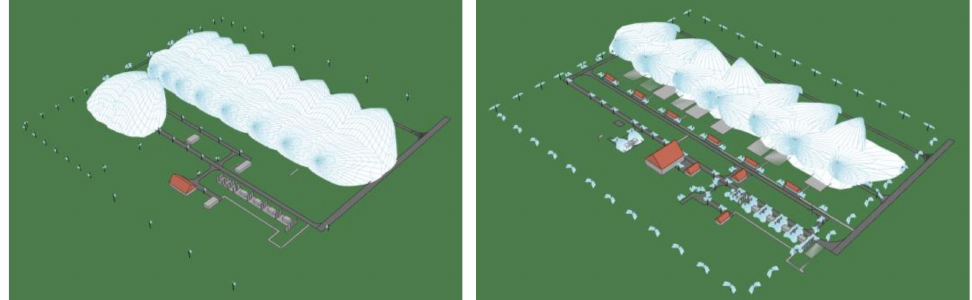
Figure 5. 3D models of light emissions from the electrical substation TR Prosenice before (left-hand side) and after (right-hand side) refurbishment.